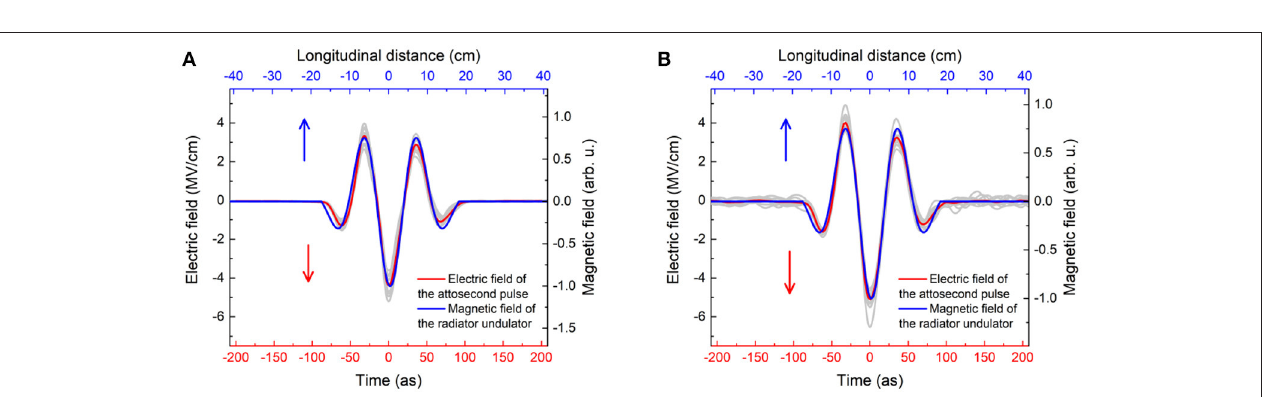
FIGURE 2 | Macroparticle distribution of 11 different simulations (gray) and their average (red) along the z axis around the temporal focus and the distributions of γ (insets) for 100pC (A) and 1000pC cases (B) .